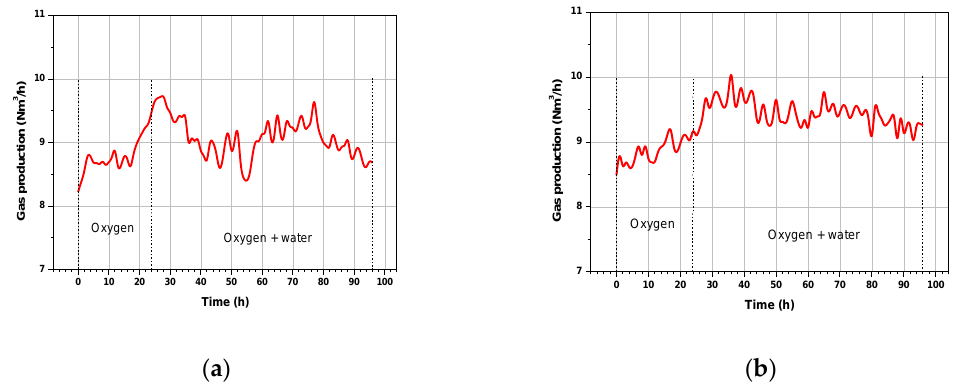
Figure 4. Gas production rates over the course of gasification experiments at 20 bar: ( a ) “Six Feet” semi-anthracite, ( b ) “Wesoła” hard coal .